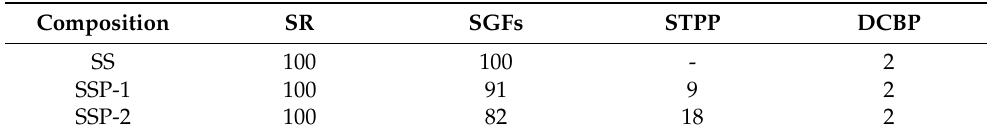
Table 1. Composites formulations (g).